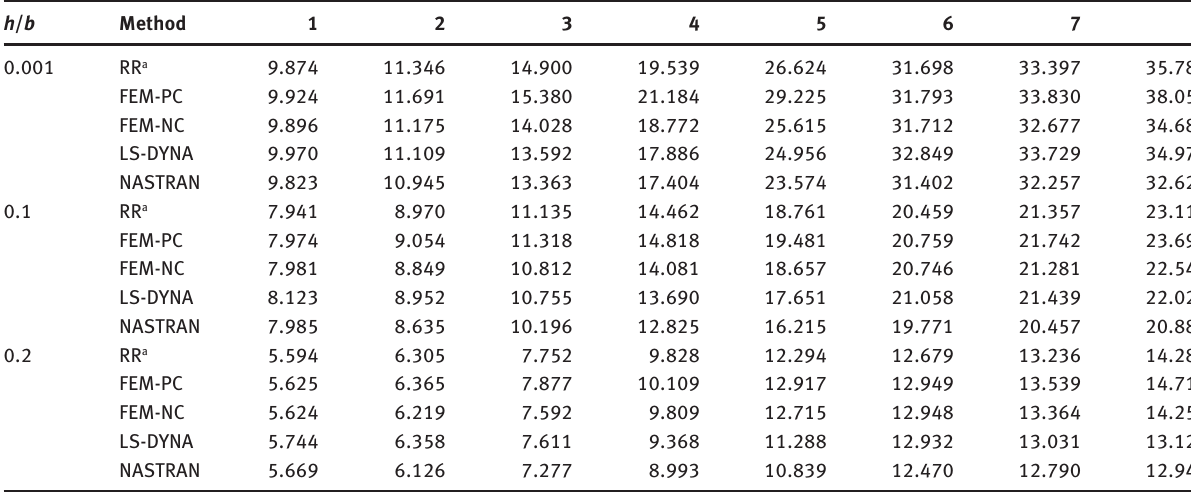
Table 3: Frequency parameter λ ω